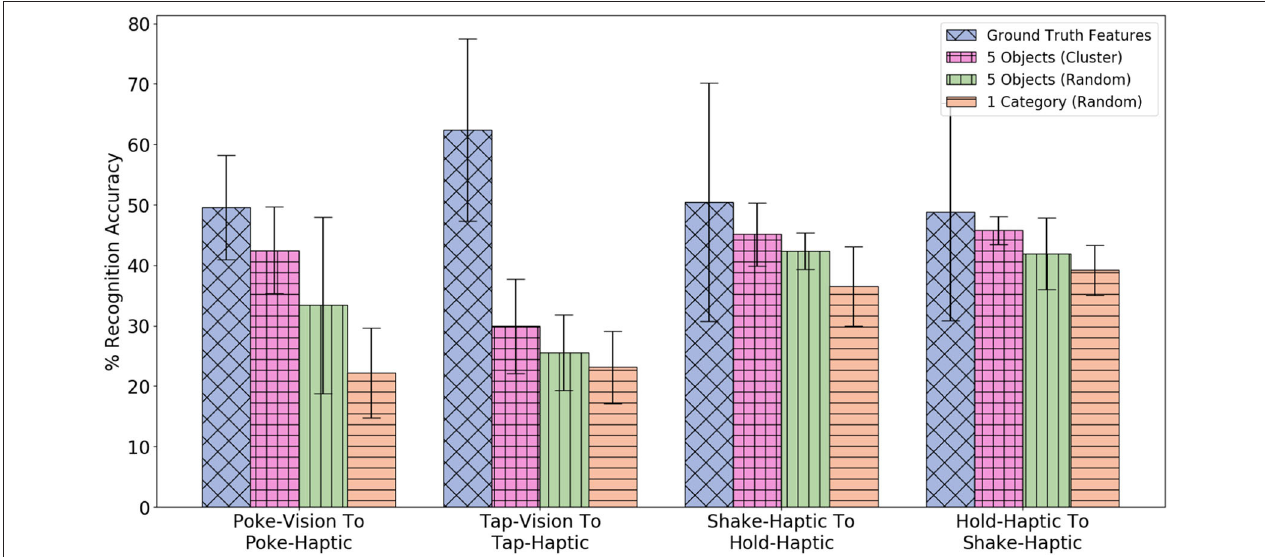
FIGURE 20 | Comparison of three different methods of selecting 5 objects for training β -VED. Note that each method selects 25 data-points for training β -VED.